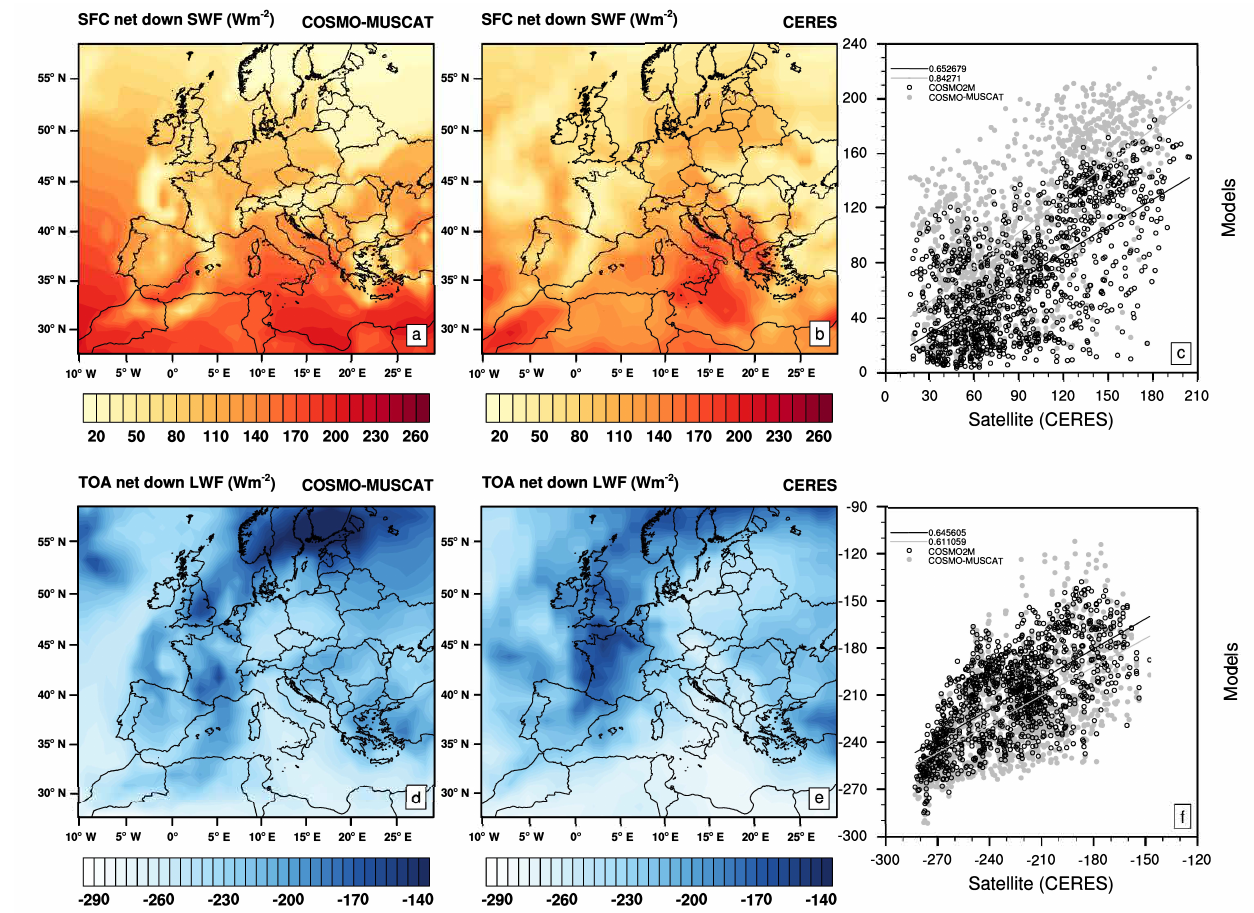
Figure 9. Comparison between shortwave and longwave fluxes at the surface and top of the atmosphere with CERES satellite fluxes and correlation between satellite (CERES) and models (COSMO2MR and